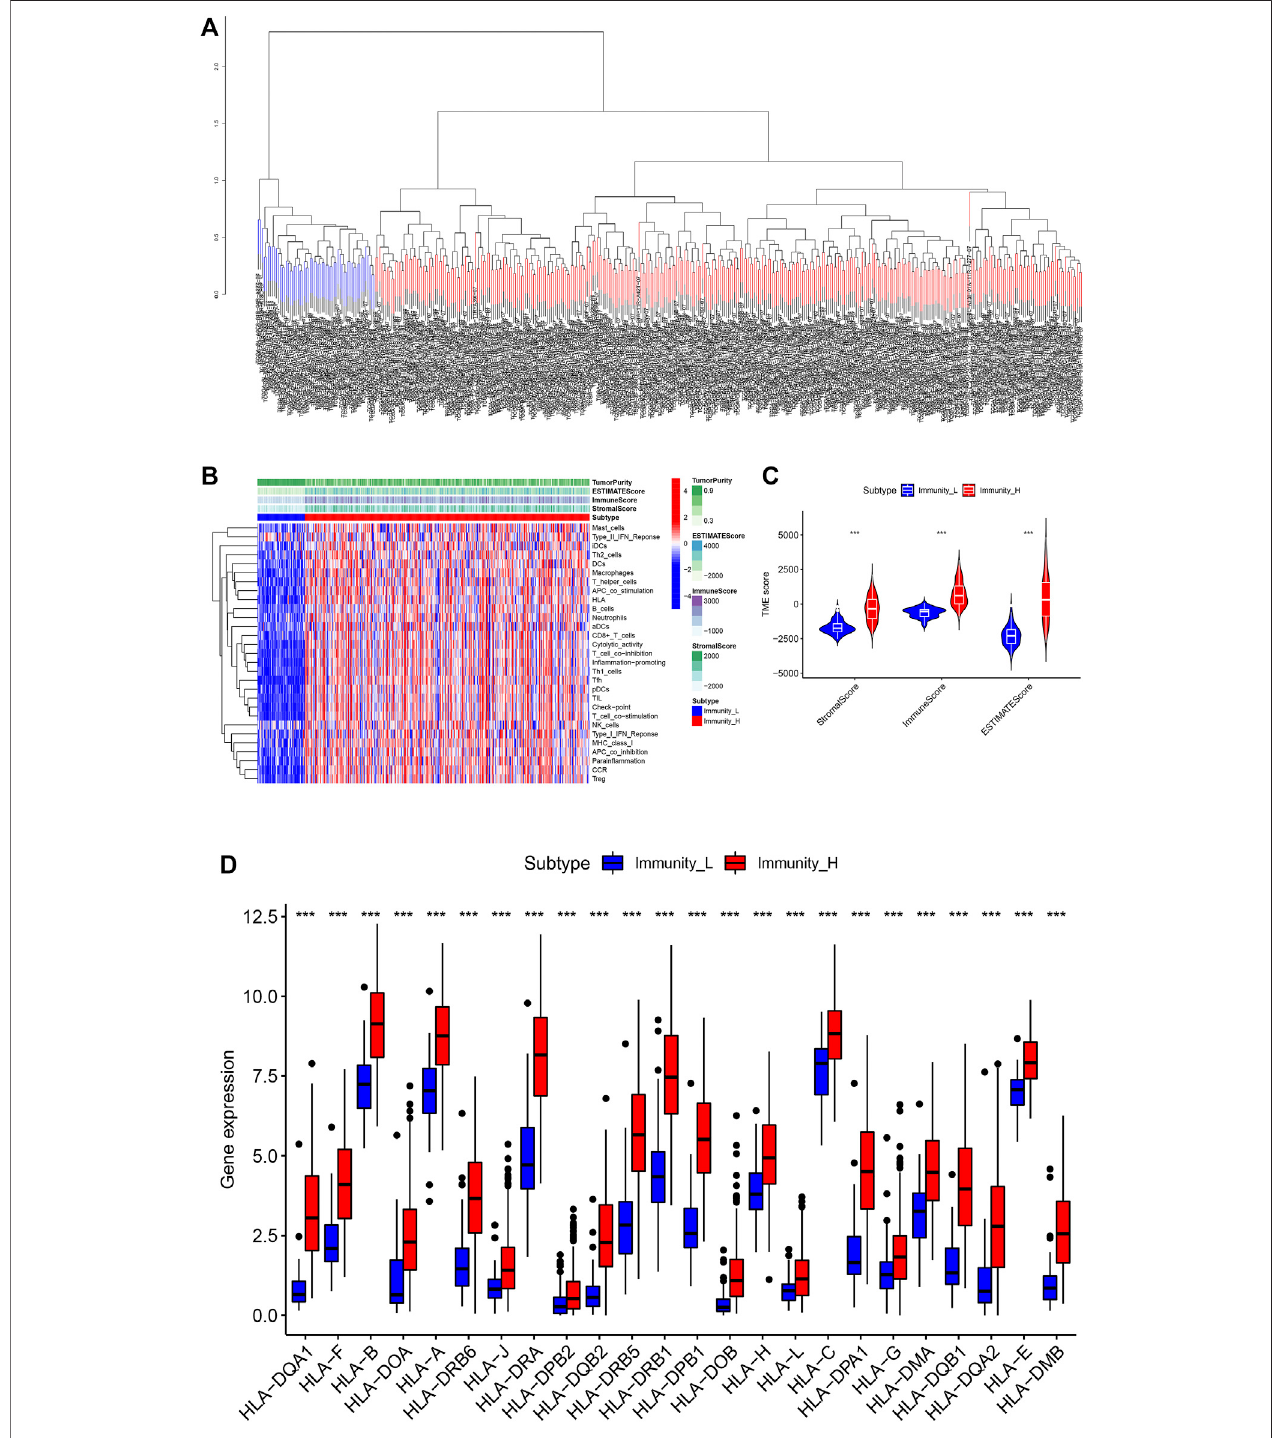
FIGURE 1 | (A) The two immune types of BLCA patients, the red part was the high immune group, the blue was the low immune group. (B) The status of immune in fi ltration and tumor microenvironment (TME) in the TCGA-BLCA cases. (C) The comparisons of StromalScore, ESTIMATEScore, and ImmuneScore between the two subtypes. (D) The comparison of expression level of HLA gene between the two subtypes. * p < 0.05, ** p < 0.01, *** p < 0.001.